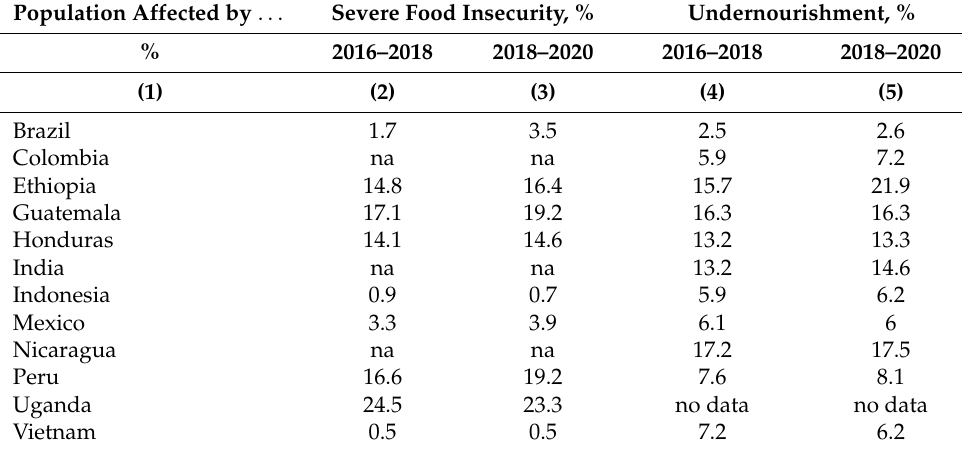
Table 3. Prevalence of food insecurity and undernourishment (3-year average, % of the total population).